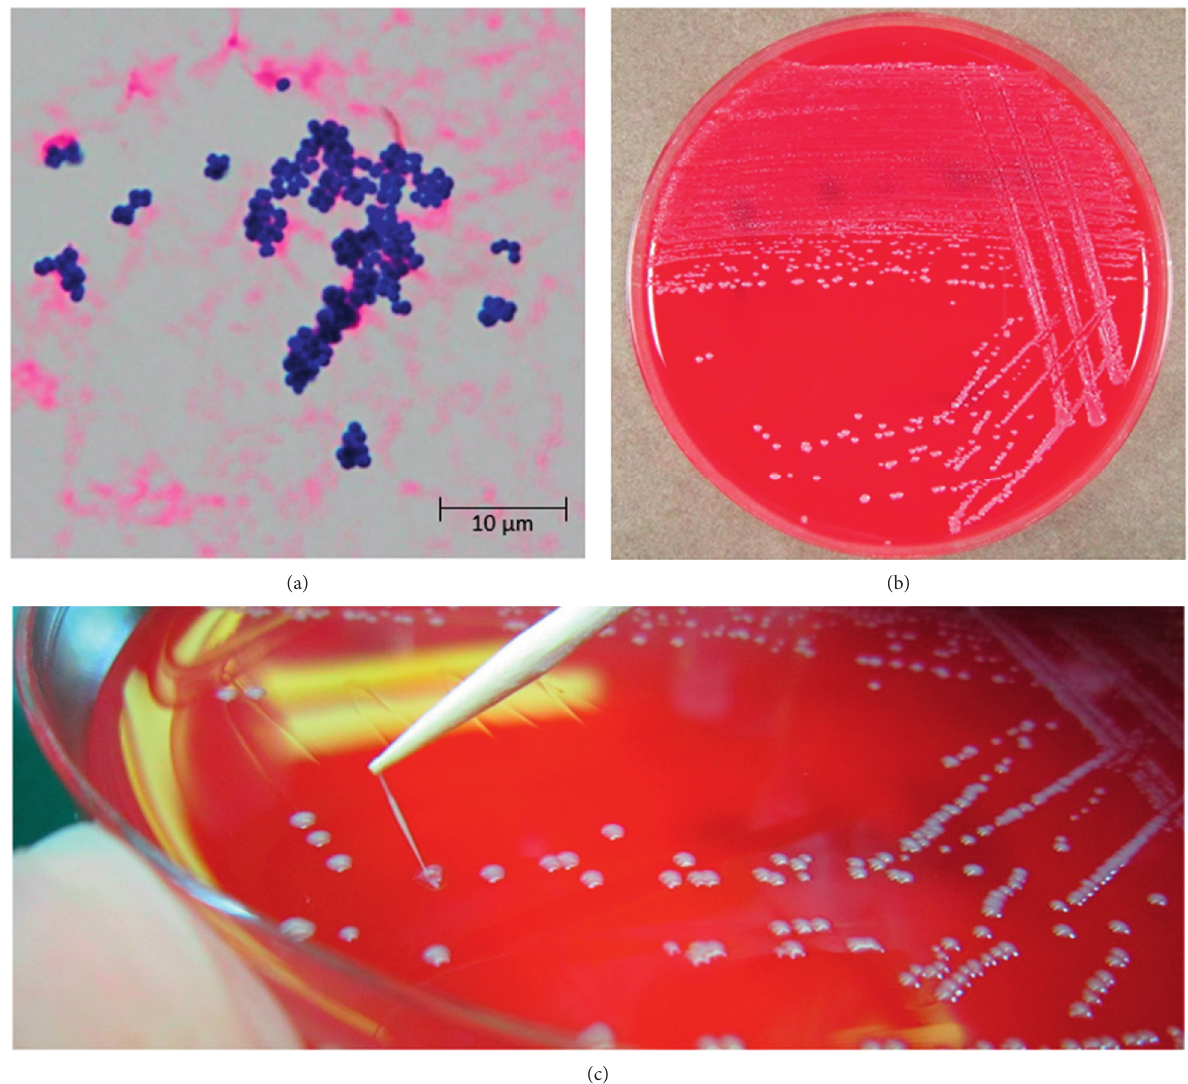
Figure 1: Macroscopic and microscopic appearance of Rothia mucilaginosa. (a) Gram staining of characteristic blue cocci from a ce- rebrospinal fluid culture at 37 ° C for 24h. (b) A blood agar plate showing R. mucilaginosa colonies in a cerebrospinal fluid sample from the patient, cultured over 24h at 37 ° C in CO 2 . (c) Sticky and slimy colonies and a positive string test Table 1: Clinical features and distribution of the MICs against antimicrobials of Rothia mucilaginosa isolated in our hospital. Case 1 Case 2 Case 3 Case 4 Case 5 ∗ Age/sex 81y/F 38y/F 7y/M 4y/M 12y/M Underlying disease Lymphoma AML Lymphoma ALL MDS Culture source Blood Blood Blood Blood CSF Infection Sepsis Sepsis Sepsis Sepsis Meningitis MIC ( μ g/mL)